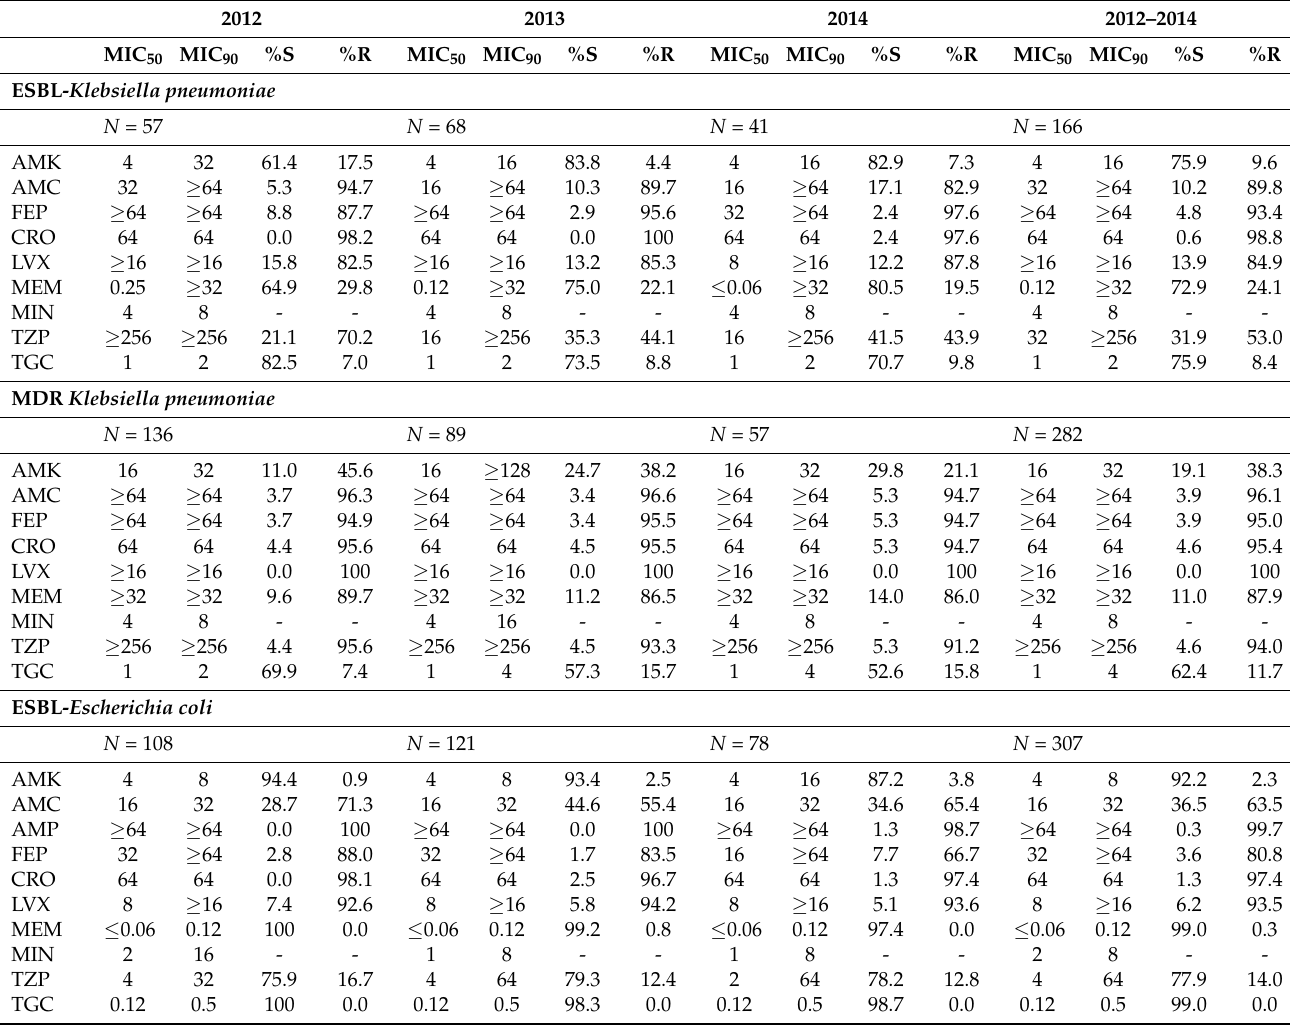
Table 3. Antimicrobial activity among resistant phenotypes of Gram-negative organisms collected from Italy between 2012 to 2014 a